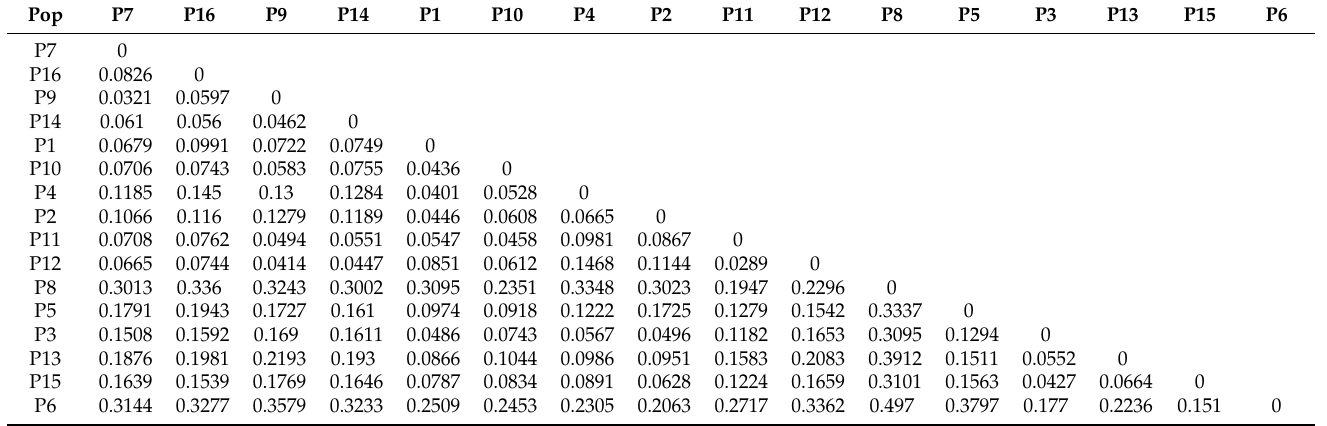
Table 5. Pairwise genetic differentiation index (FST) estimates for groups resulting from the cluster